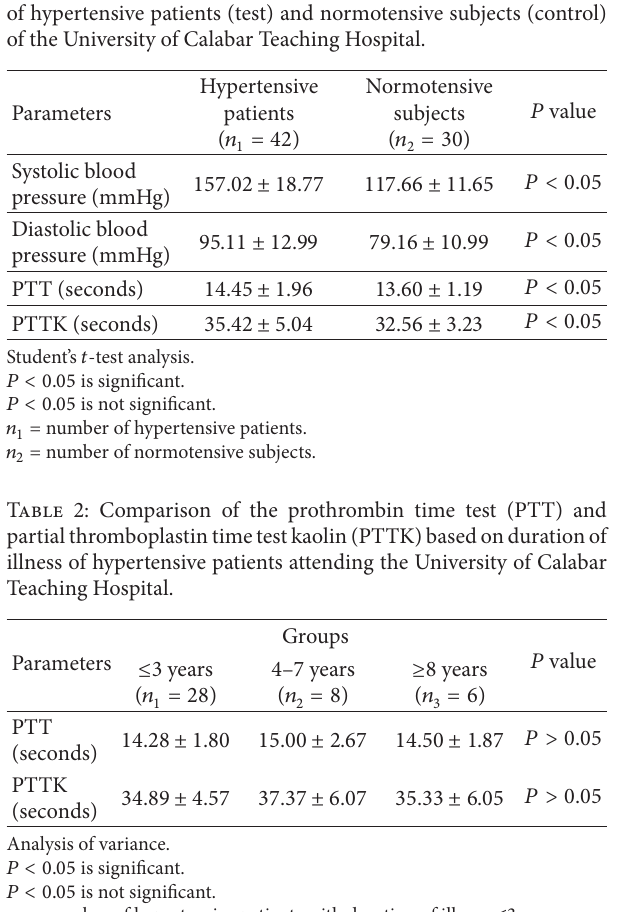
Table 1: Mean systolic pressure, diastolic pressure, prothrombin of hypertensive patients (test) and normotensive subjects (control) of the University of Calabar Teaching Hospital.